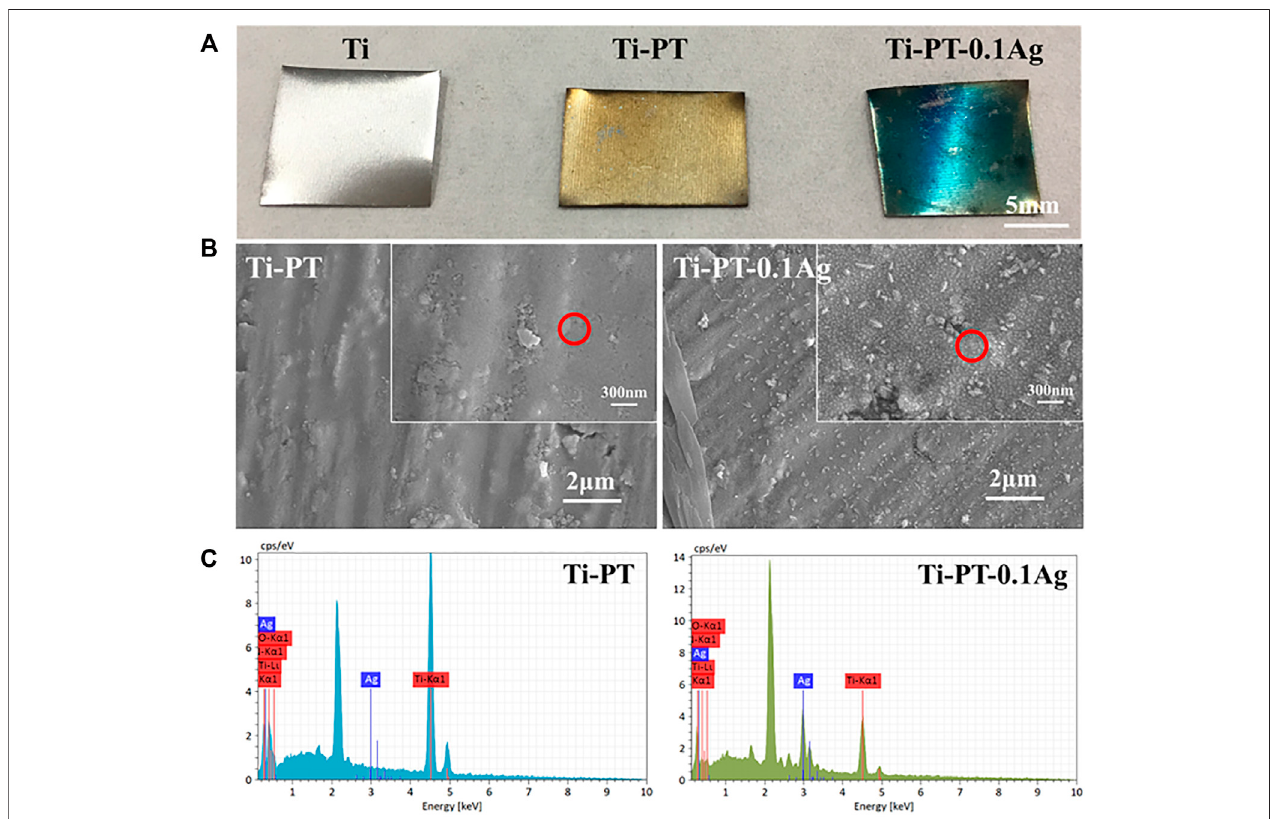
FIGURE1|(A) DigitalpicturesofTi,Ti-PT,andTi-PT-0.1Agsamples. (B) Surfacemorphologyandmicrostructure ofTi-PTandTi-PT-0.1Ag. (C) EDSspectrafrom the position marked by red